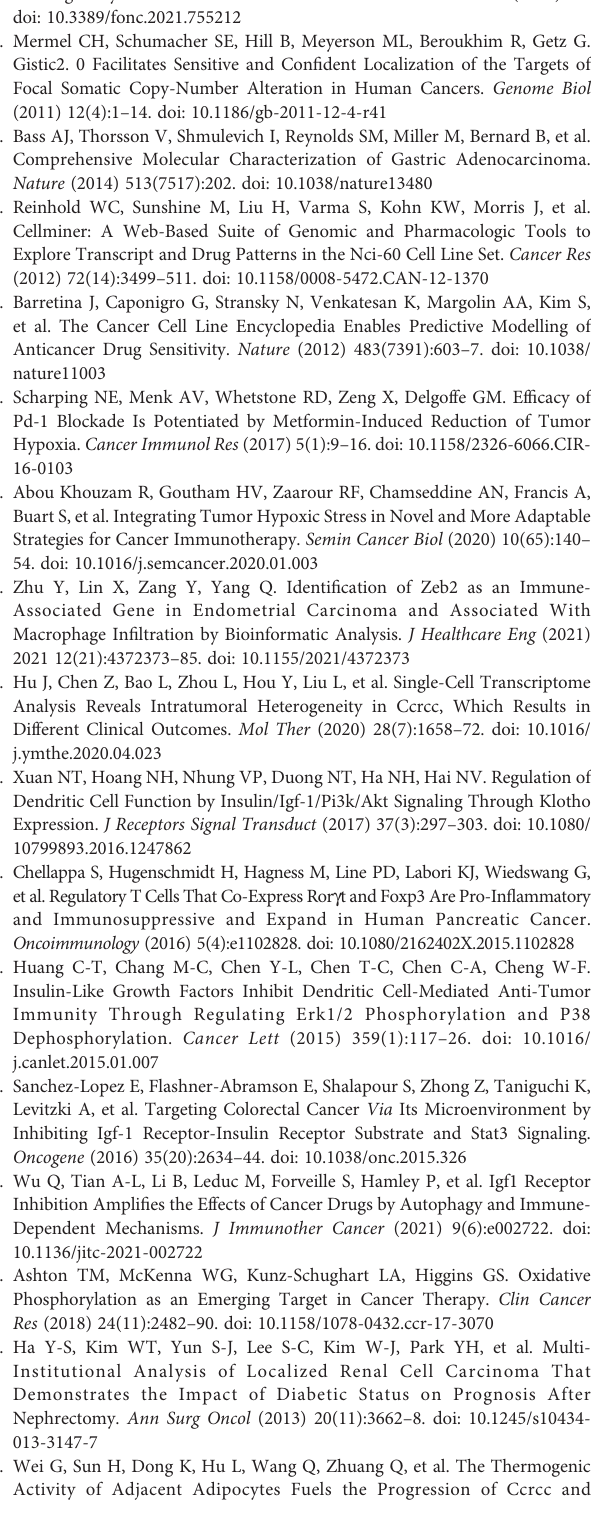
Supplementary Table 3 | Recurrently ampli fi cation and deletion regions in the three subtypes calculated by GISTIC2.0.